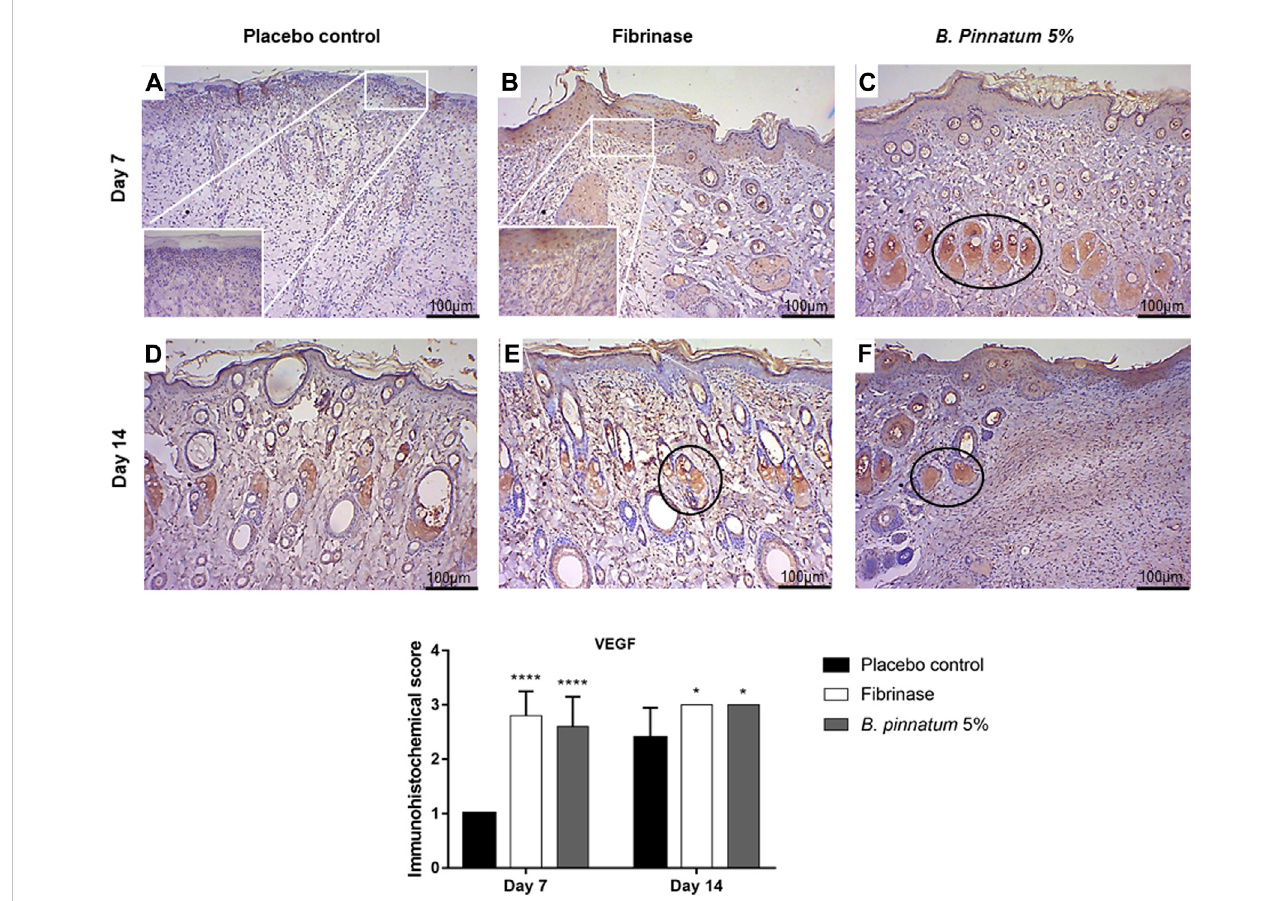
FIGURE 7 Immunohistochemical analysis of VEGF in skin biopsies showing the cut in the transverse direction. View under a bright fi eld microscope at 10 × magni fi cationandzoomat40×magni fi cation.Placebo,Fibrinase ® ,andgelcontaining B.pinnatum leafextractat5%controlgroupsevaluatedonday7 (A,B,C, respectively) and on day 14 (D,E,F, respectively). Circle, strong expression of VEGF. Statistical difference demonstrated by Mann – Whitney test ( n = 5), * p < 0.05 and **** p < 0.0001 vs . placebo